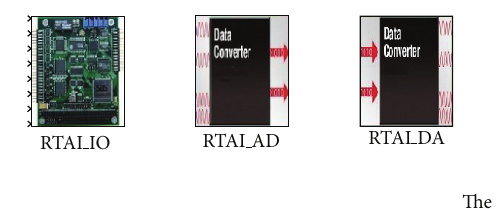
Figure 7: Driver library of the DAQ Card ADT652.